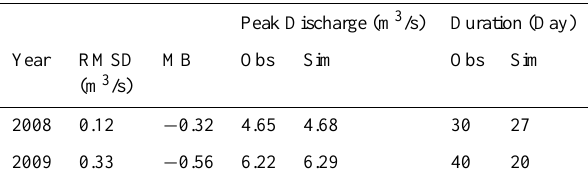
Table 3. Evaluation of simulating spring basin discharge with root mean square difference (RMSD, m 3 s − 1 ) , model bias (MB), peak discharge (m 3 s − 1 ) , and duration of discharge (day) in 2008 and 2009 simulation periods. Sim and Obs are simulation, and observa- tion,